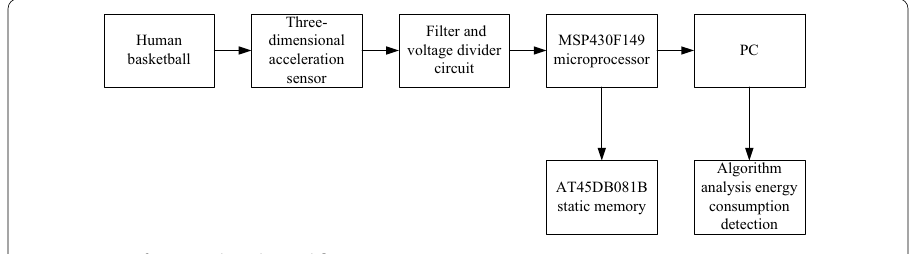
Fig. 2 System framework and signal